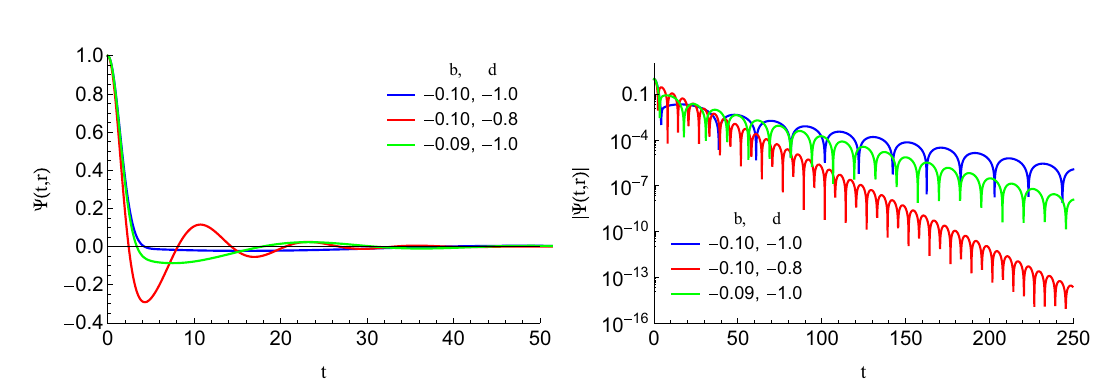
Fig. 1 This figure evaluated at r = 2 ( r e < 2 < r c ) for (cid:16) = 2 and c = 0 . 3. The left (right) panel indicates the (absolute) value of the wave function (cid:14) ( t , r ) of gravitational perturbations as a function of time